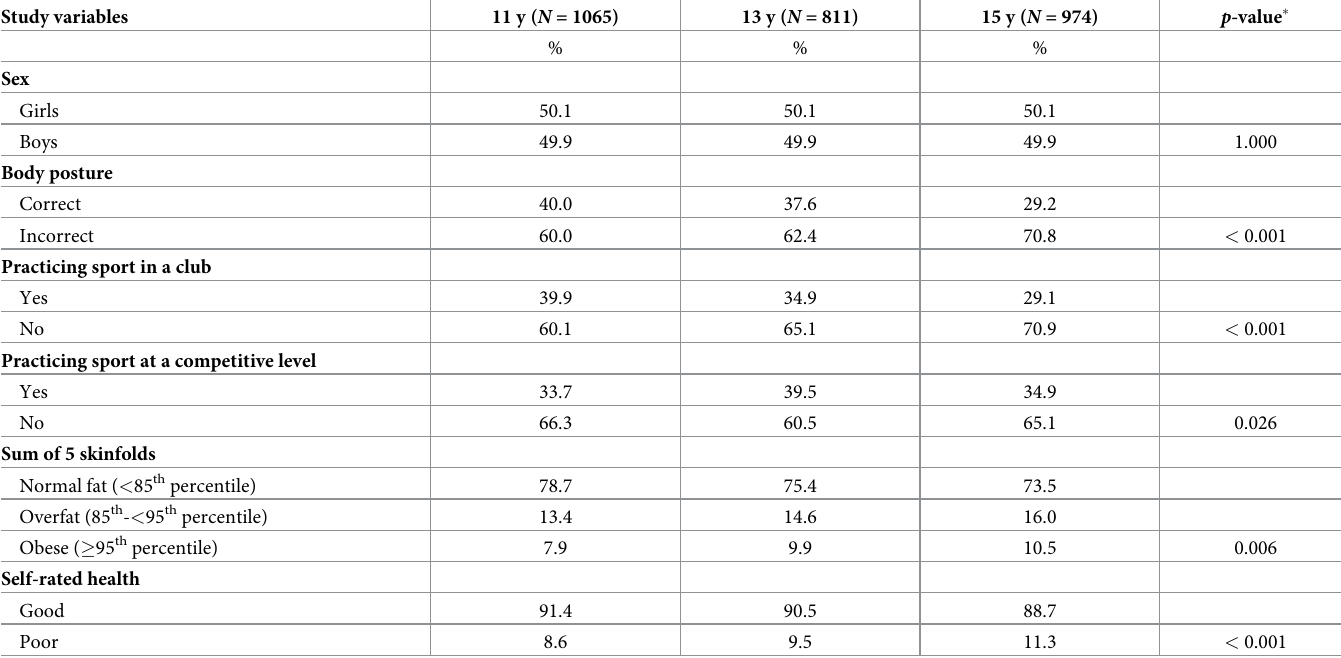
Table 1. Descriptive statistics of study participants at the ages of 11 y, 13 y and 15